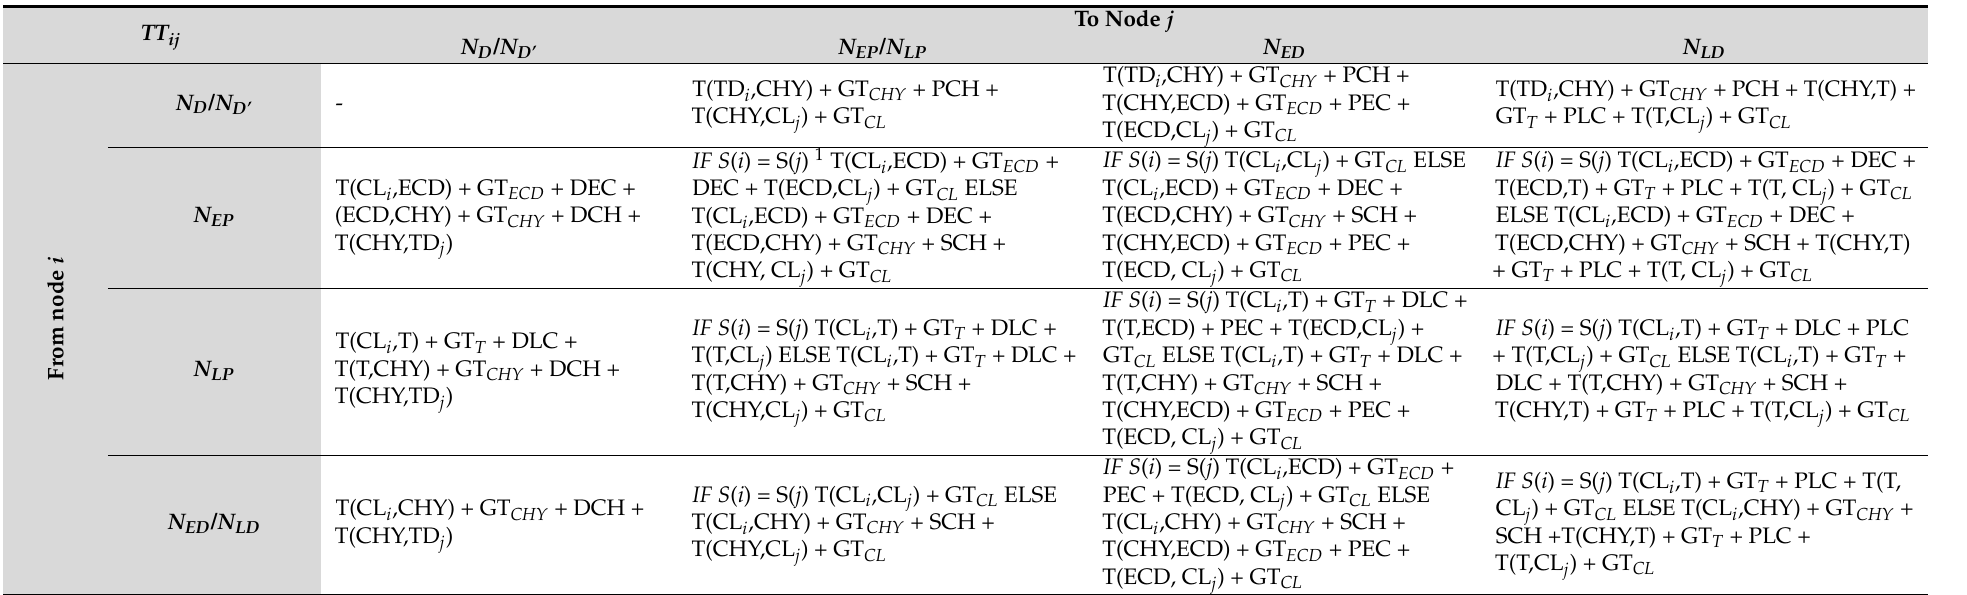
Table 1. Transfer Time on Arc ( i , j ) for Scenario